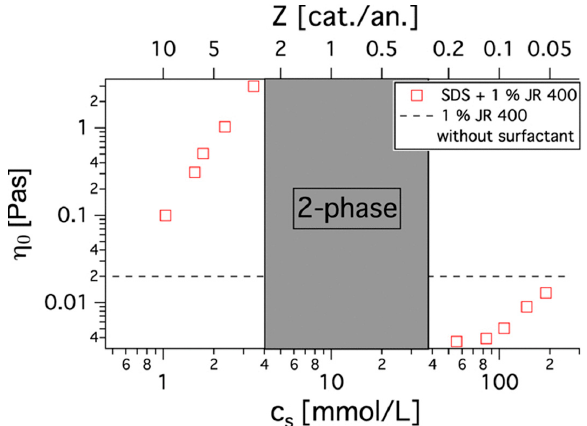
Figure 15. Viscosity of 1 wt% JR 400 polyelectrolyte with increasing concentration of SDS. Z represents the charge ratio between cation and anion. The dashed line is the viscosity of the polyelectrolyte solution alone. Reprinted from Hoffmann, I.; Simon, M.; Farago, B.; Schweins, R.; Falus, P.;